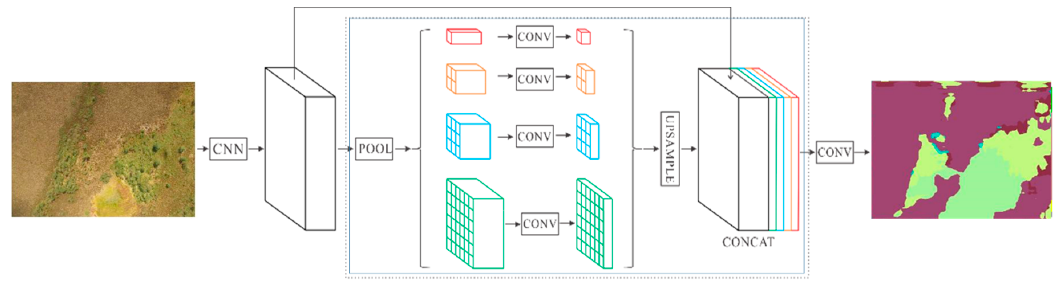
Figure 9. Pyramid Scene Parsing Network (PSPNet) architecture for semantic segmentation for bog-ecotope semantic